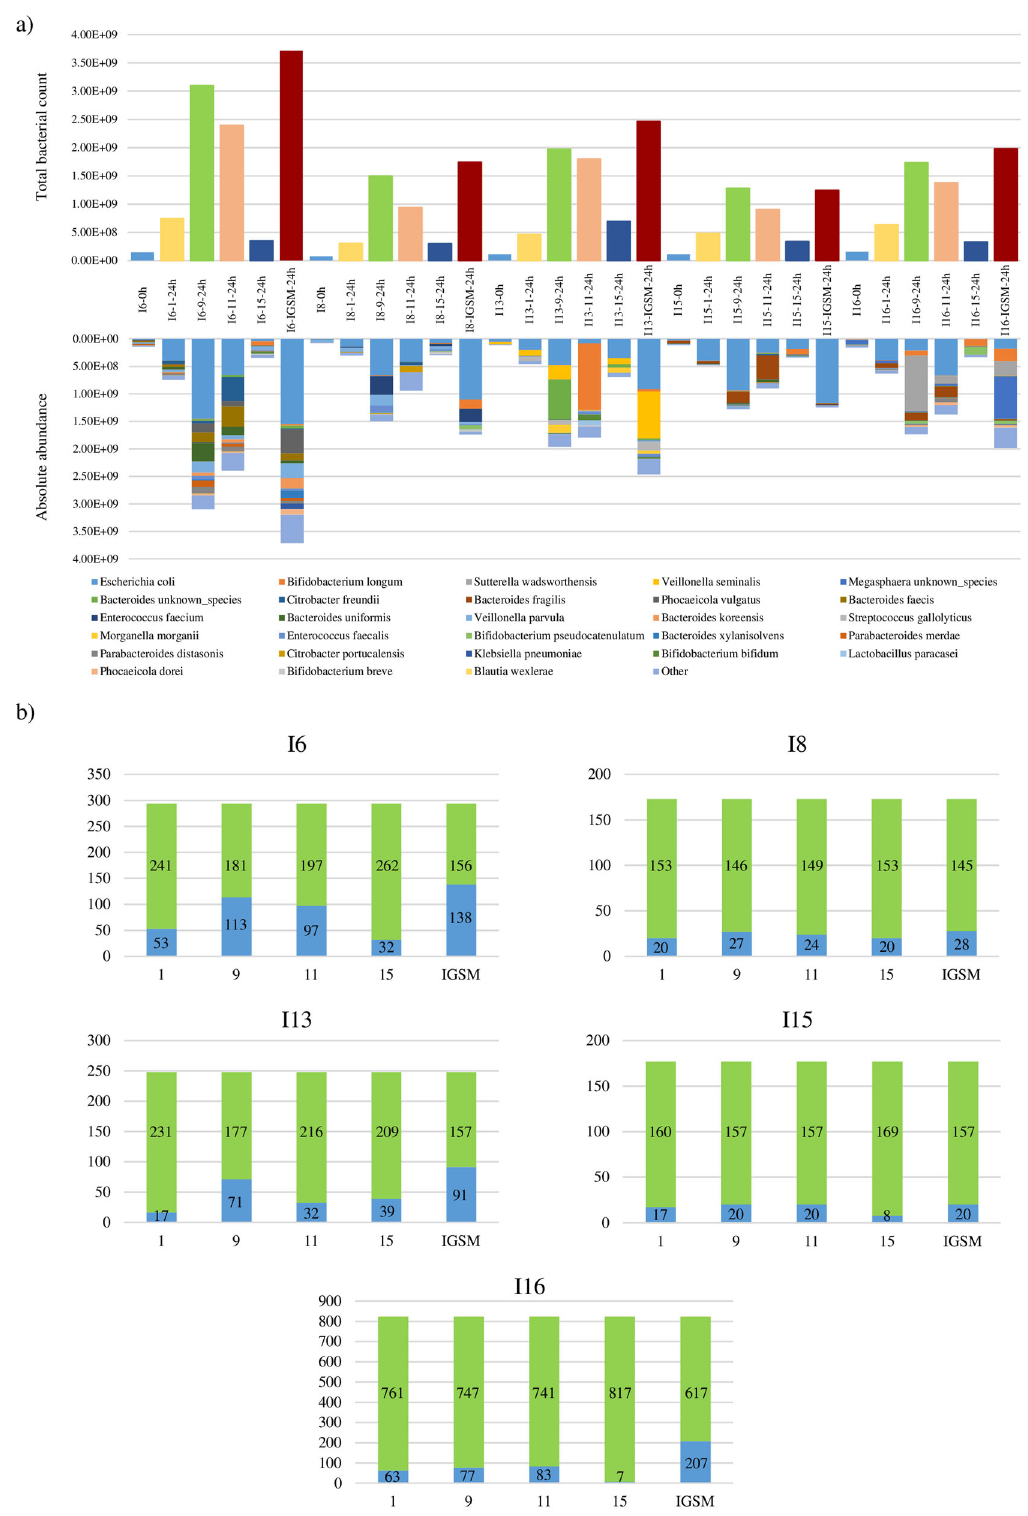
Fig. 3 Validation of the IGSM formulation. Panel a depicts the fl ow cytometry-based bacterial counts and absolute abundance-based taxonomic pro fi les obtained by cultivating fi ve infant fecal samples in four different culture media as well as in IGSM. Panel b reports the number of bacterial species showing a 10-fold increase in bacterial enumeration higher (light blue) or lower (green) than the inoculum bacterial count. All data are expressed as average of the two obtained replicates per each